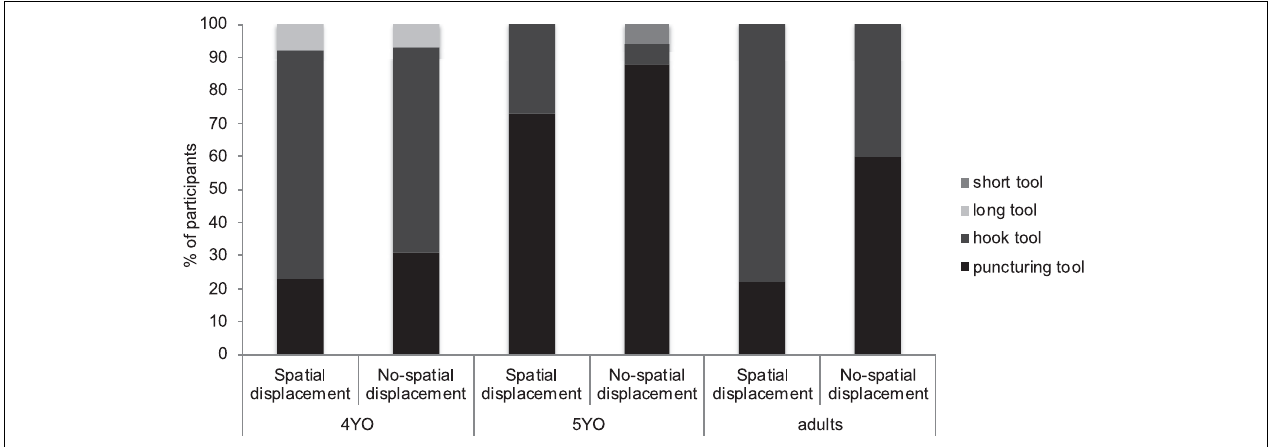
FIGURE 3 | Percentage of 4-year-olds (4YO), 5-year-olds (5YO) (Experiment 1) and adults (Experiment 2) selecting each of the possible tools (i.e., short tool, long tool, hook tool and puncturing tool) in those instances in which they only selected one tool in their first tool-choice opportunity. Data is grouped by Spatial-displacement condition and No-spatial-displacement condition.